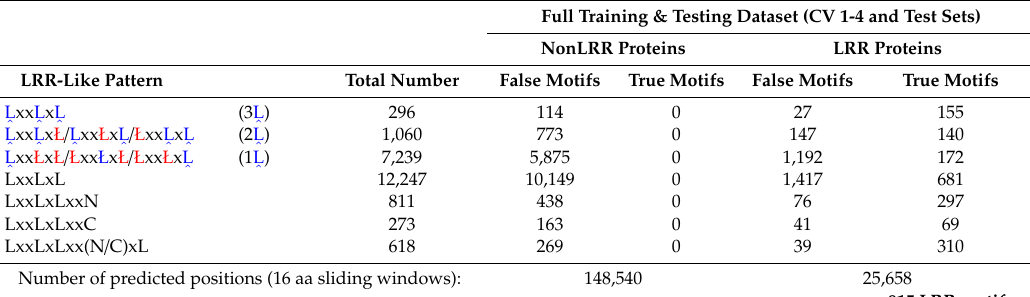
Table 1. Occurrence of LRR sequence patterns in the overall dataset used to train the machine learning (ML)